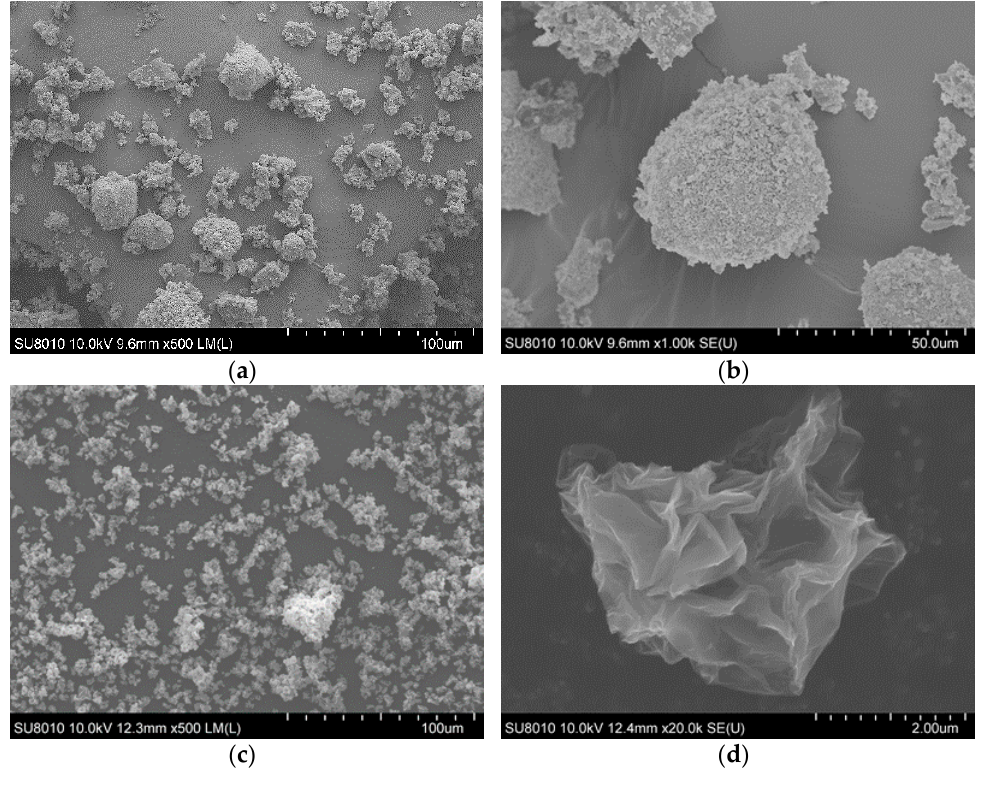
Figure 2. SEM images of H ( a , b ) and GO A ( c , d ).